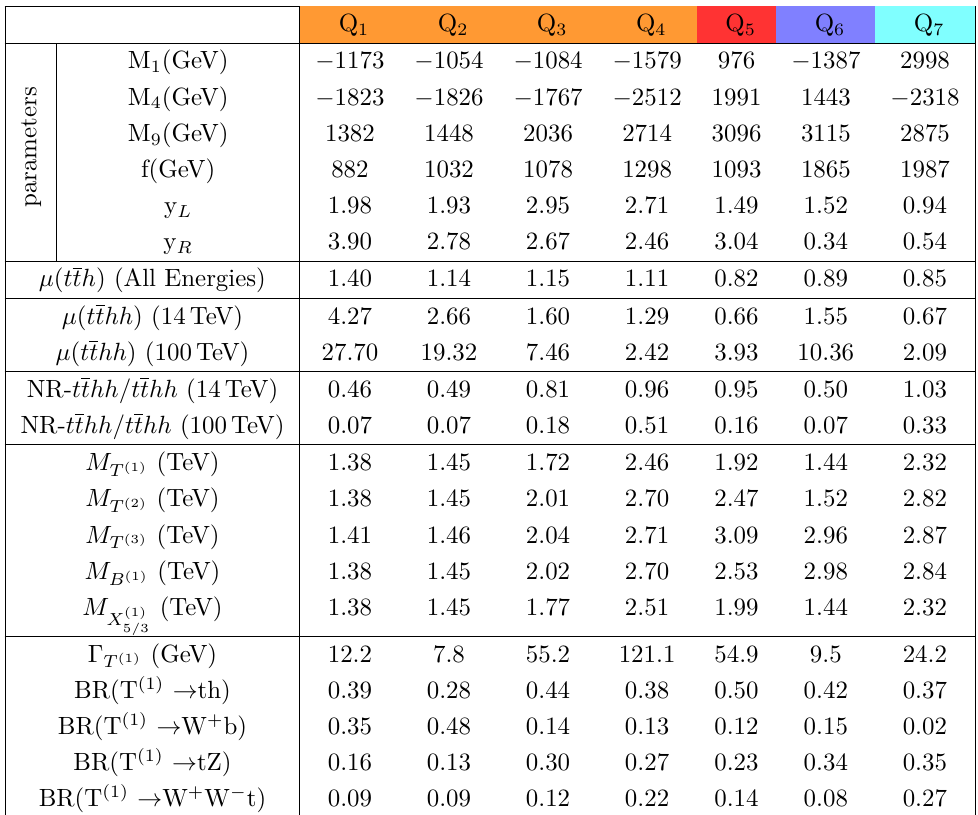
Table 2 . Properties of selected example points in the low scale MCHM 14 . Column headings indicate region, with red and orange meaning respectively Regions I and III (with same sign M 1 and M 4 ) and blue and cyan respectively for regions II and IV (with opposite sign M 1 and M 4 ). the lowest M value is 2 TeV. The first four points ( Q 9 example points for this